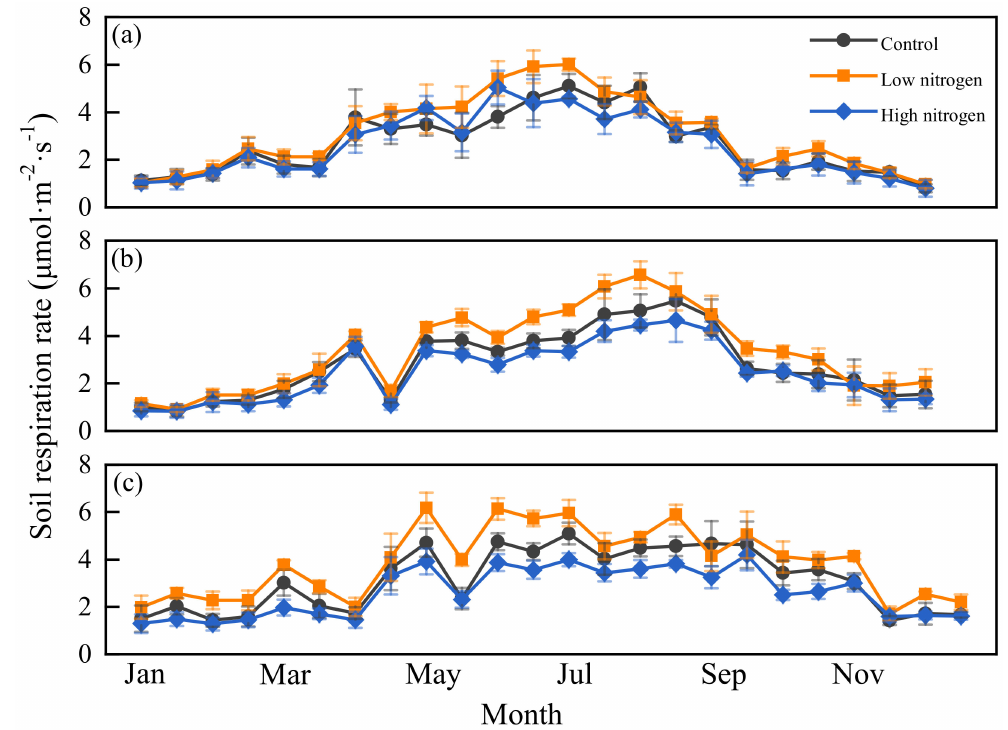
Figure 1. Monthly dynamics of soil respiration rate under di ff erent N treatments in 2013 ( a ), 2014 ( b ), and 2015 ( c ). Error bars represent standard deviation ( n =